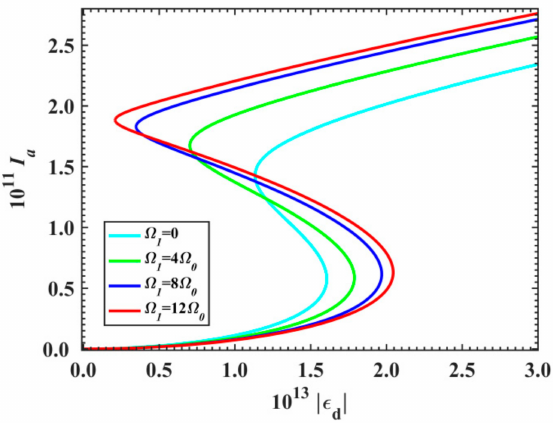
Figure 3. Curves of the mean intracavity photon number versus the intensity of the pump field under the condition with di ff erent the controlling field Ω 1 , where γ 13 = γ 12 = γ 14 = γ , ∆ 1 = γ , ∆ = ∆ = 2 γ , ∆ = 20 γ , Ω = 4.5 Ω = 6 π × 10 6 2 3 0 2 0 , g